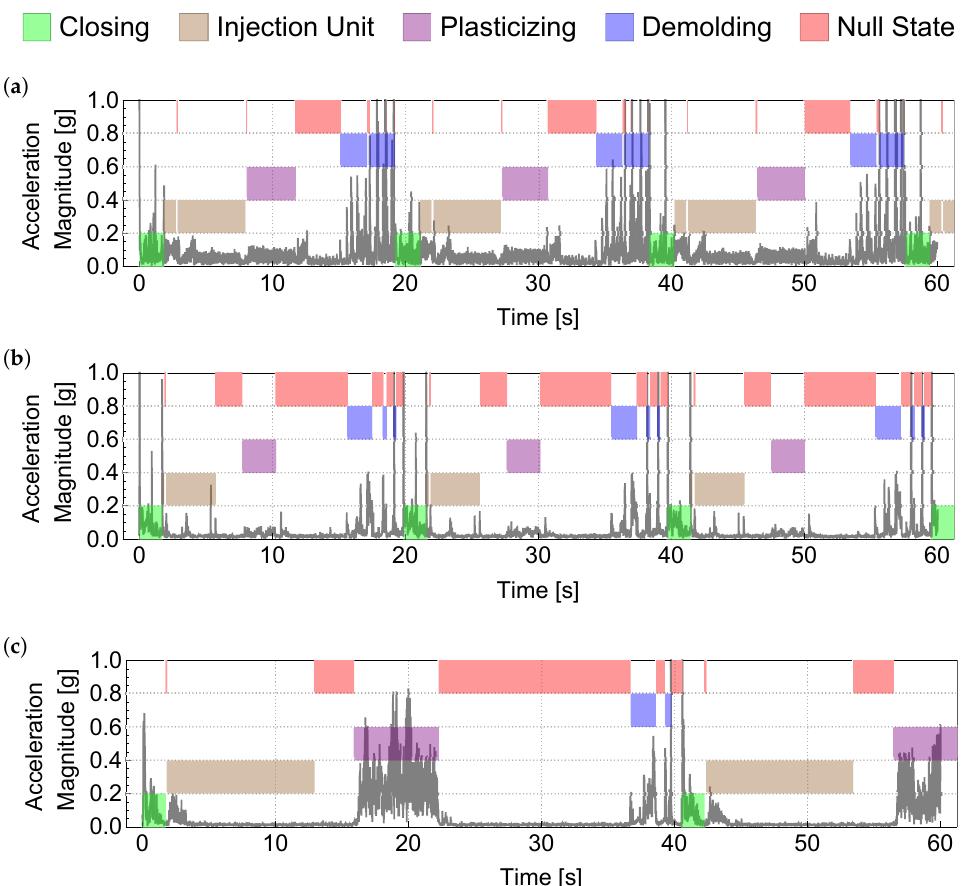
Figure 2. Depiction of excerpts from three different datasets ( a – c ). The injection molding cycles shown in ( a , b ) are rather short cycles of slightly more than 20 s, ( c ) shows a slightly longer cycle of about 40 s in